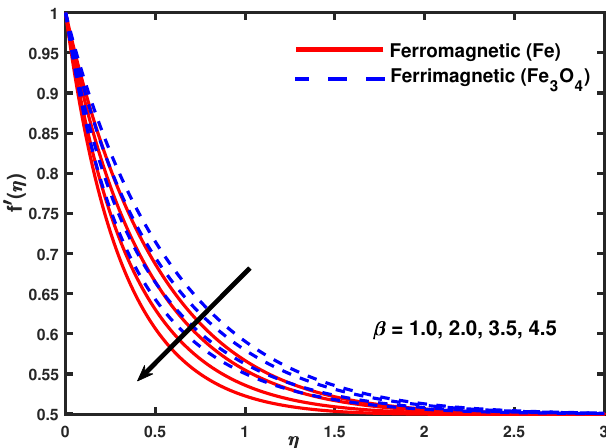
Figure 5. Impact of magnetic nano-particles and ferromagnetic parameter ( β ) on the velocity profile f (cid:48) ( η ) .